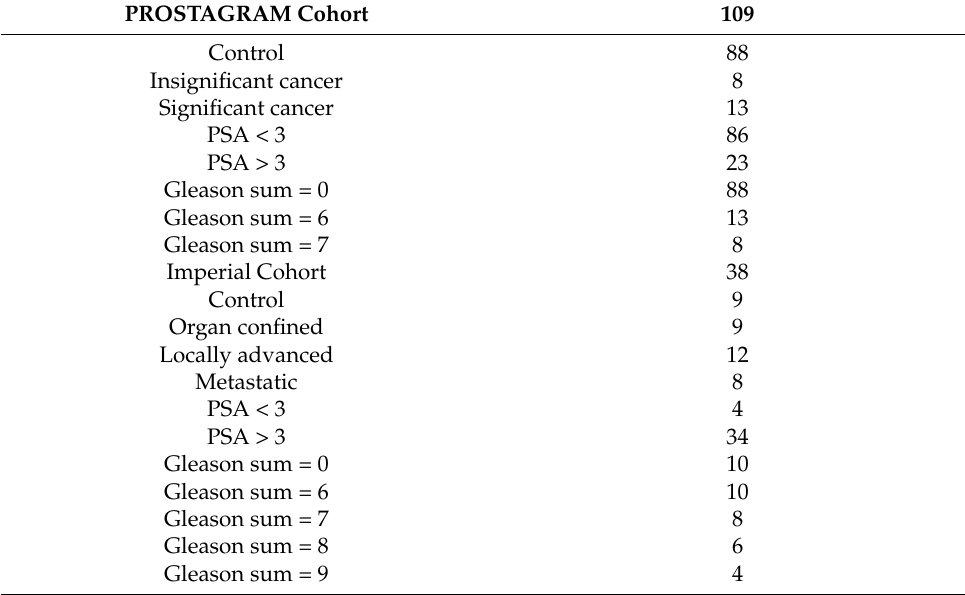
Table 2. Number of patients in each cohort according to their clinical characteristics. PROSTAGRAM